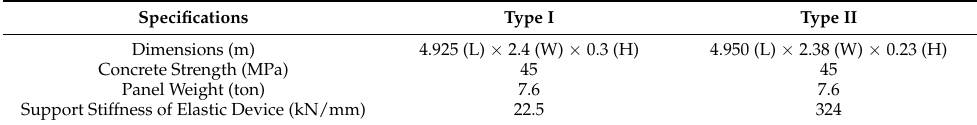
Table 1. Specification of